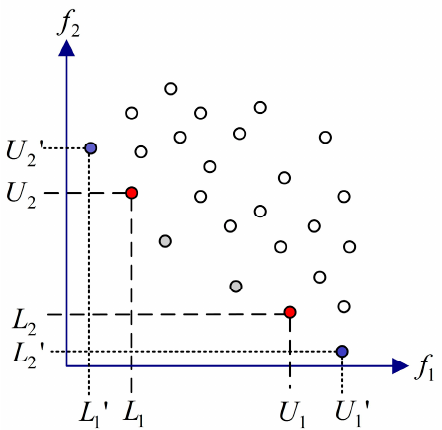
Figure 3. Normative knowledge.